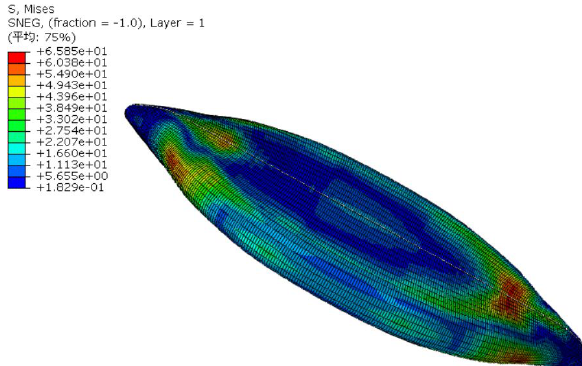
Figure 15: Distribution of overall stress